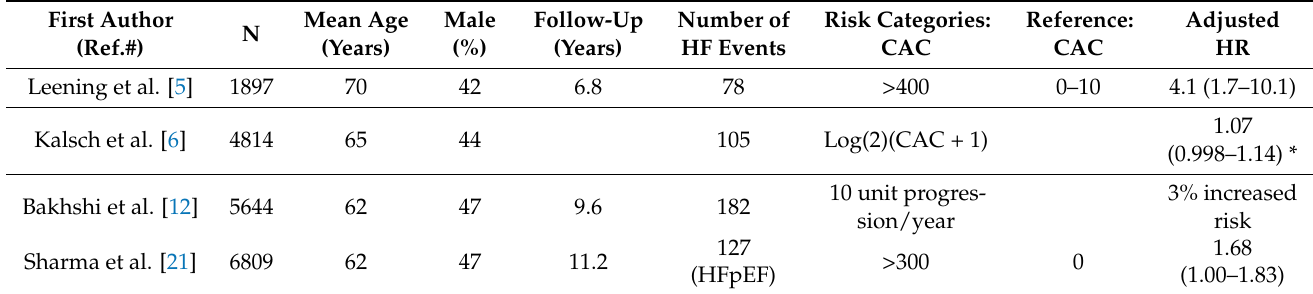
Table 1. The power of coronary artery calcification as a risk predictor for heart